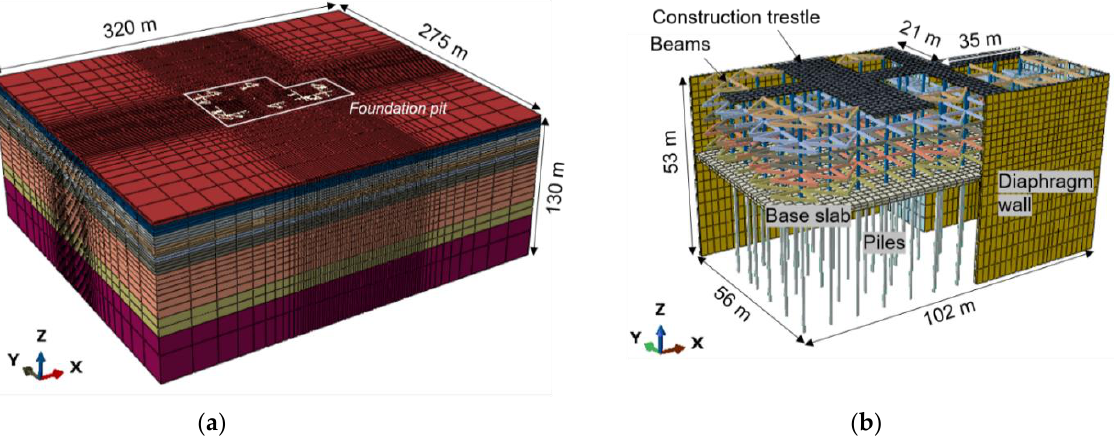
Figure 21. Developments of the axial strut force at ZC15 and ZC16. ( a ) Geometry and mesh of the whole model. ( b ) Geometry and mesh of the retaining structures.